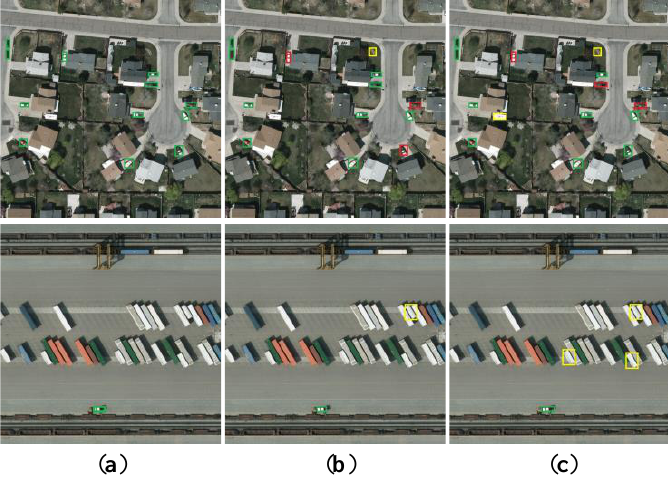
Figure 11. The detection results for faster RCNN and SSD512: (a) test image, (b) faster RCNN, (c) SSD512.